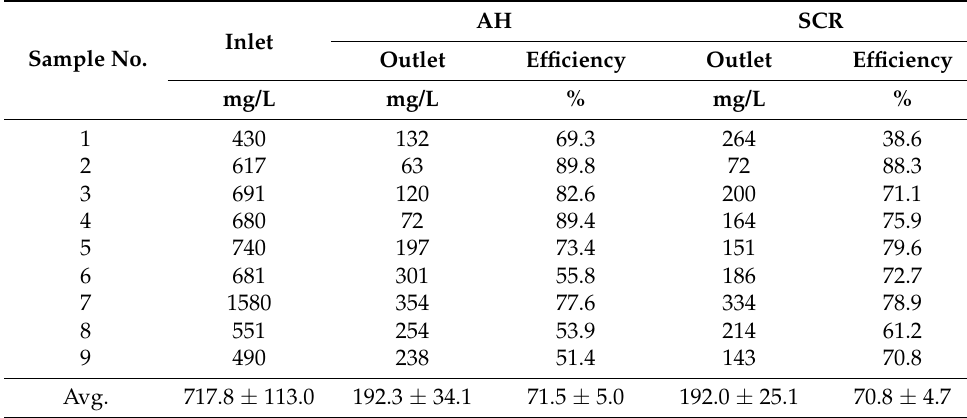
Table 1. Inlet and outlet COD and removal efficiencies at preliminary stage.